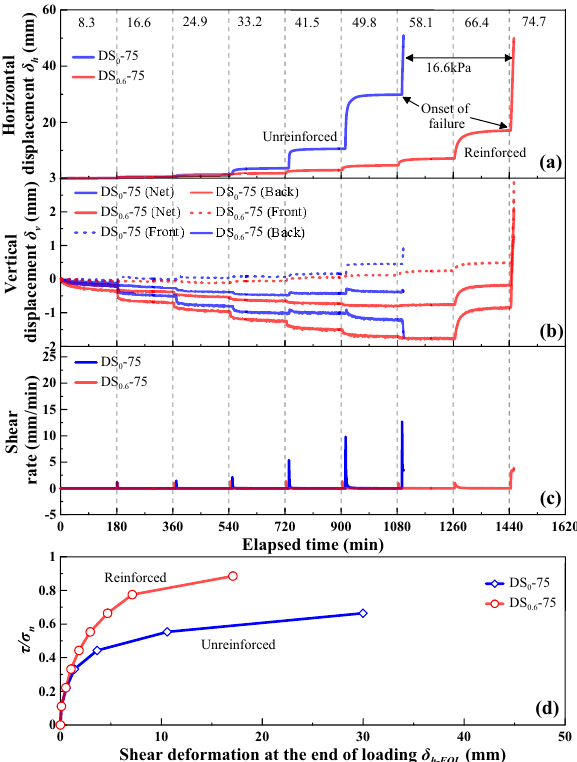
Figure 6. Shear behaviour for the reinforced specimen ( ω = 18% and %waste straw = 0.6) and the unreinforced specimen ( ω = 18%) under σ n = 75 kPa: ( a ) shear displacement ( δ h ) versus elapsed time relationship, ( b ) vertical displacement ( δ v ) versus elapsed time relationship ( c ) shear rate versus elapsed time relationship, and ( d ) ratio of shear stress to total normal stress ( τ / σ n ) versus shear displacement at the end of each increment of shear load ( δ h-EOL )